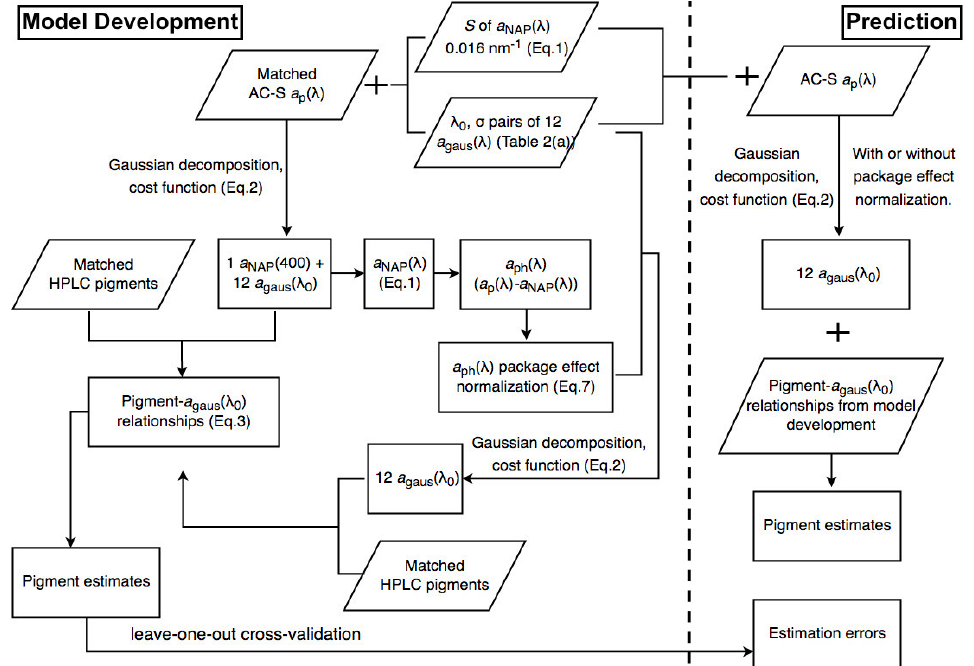
Figure 2. Schematic overview of the steps of applying Gaussian decomposition for phytoplankton pigment retrieval.